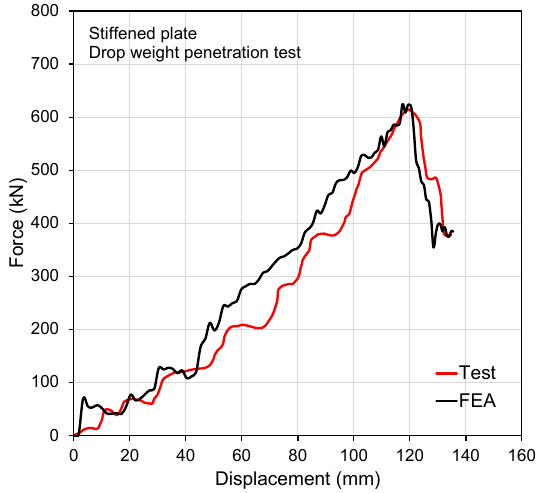
Figure 4. Force–displacement curves for the stiffened panel simulations.